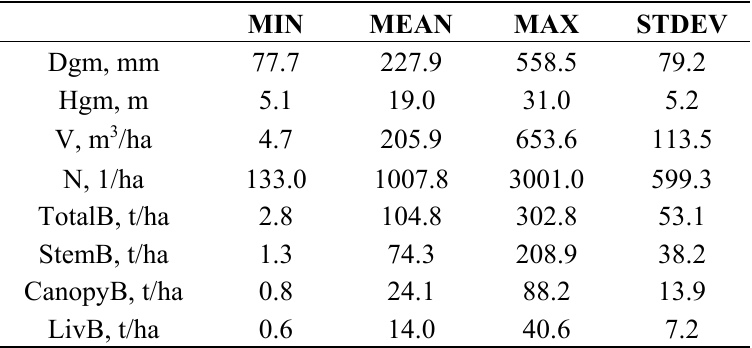
Table 1. Descriptive statistics of measured forest